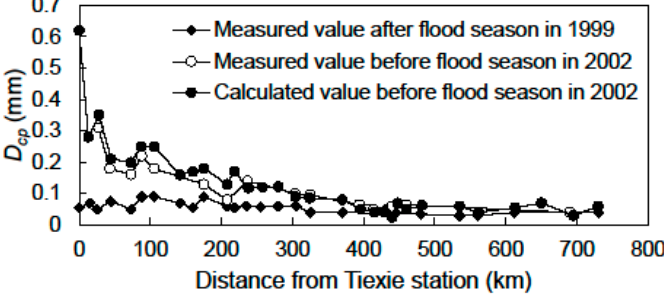
Figure 9. Verification results of the mean size of the bed material for the major channel surface of the middle and lower Yellow River before the flood season in 2002.